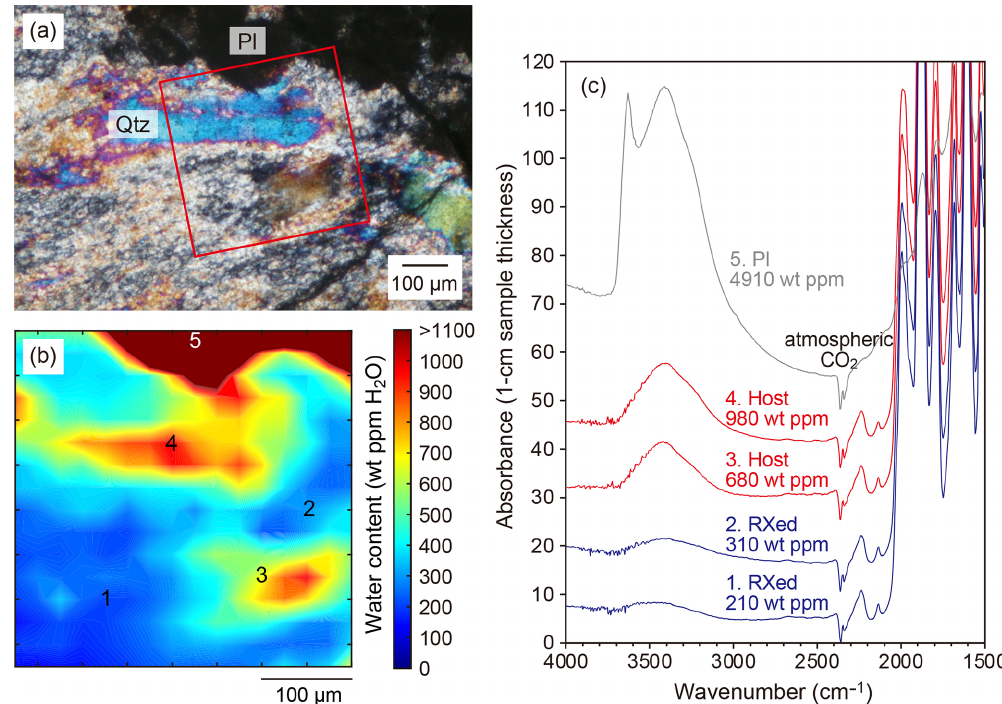
Figure 7. IR mapping results for the weakly deformed sample. The sample thickness is 103µm. (a) Optical photomicrograph under cross- polarized light. The IR mapped area is shown with a red square. (b) Water distribution. Numbers represent raw IR spectra in (c) . Color- coded water contents up to 1100wtppm H 2 O are for quartz, and those above are for plagioclase around no. 5 in (b) . “RXed” in (c) means